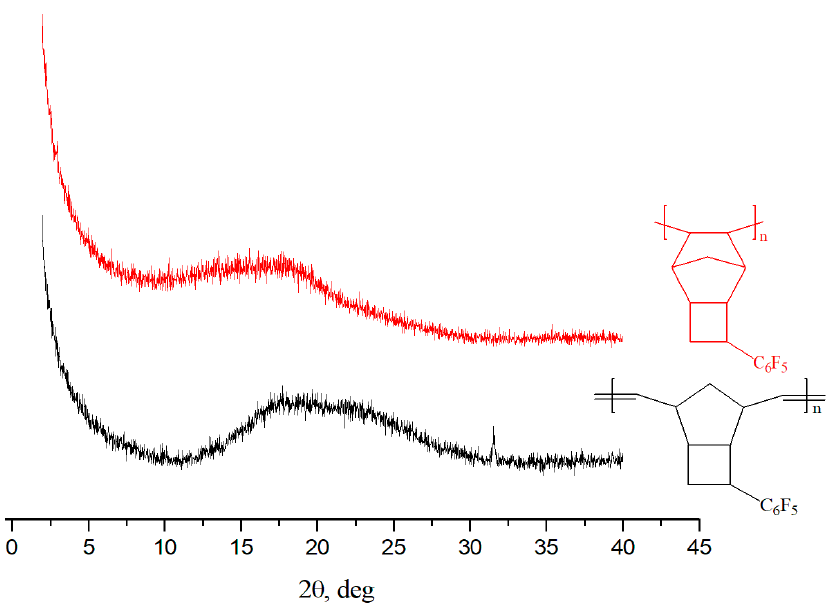
Figure 6. Wide-angle X-ray diffraction (WAXD) patterns for APF5 and MPF5. Table 4. The results of WAXD study of some addition and metathesis polynorbornenes.